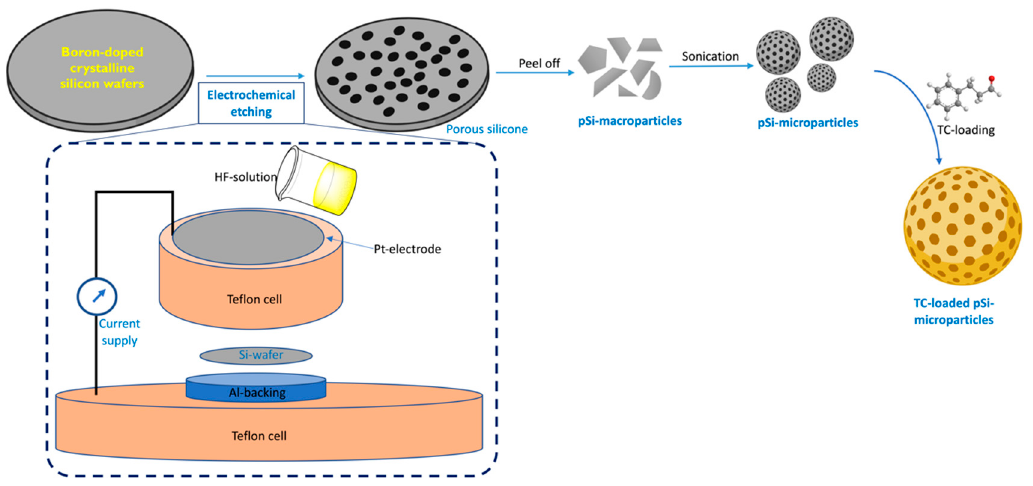
Figure 1. Schematic illustrating the synthesis of the pSi-TC